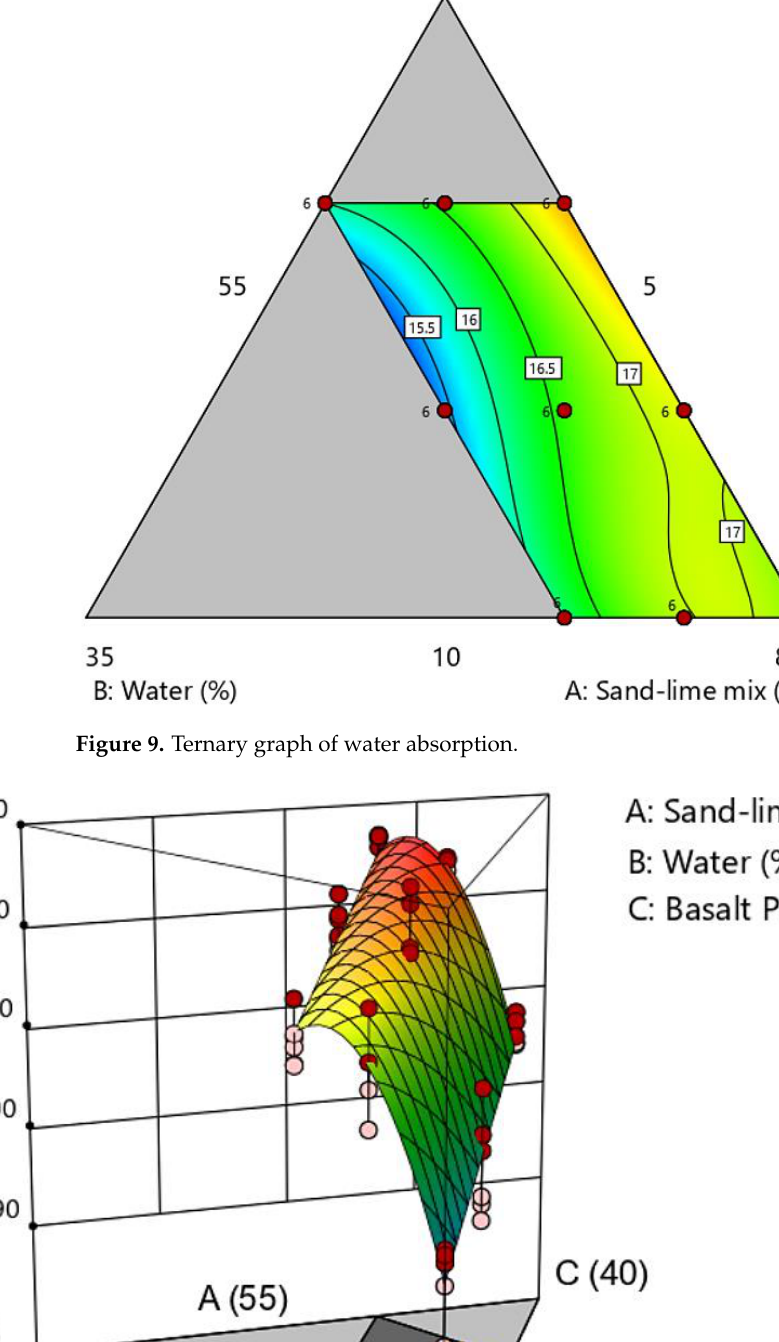
Figure 8. Water absorption of samples.